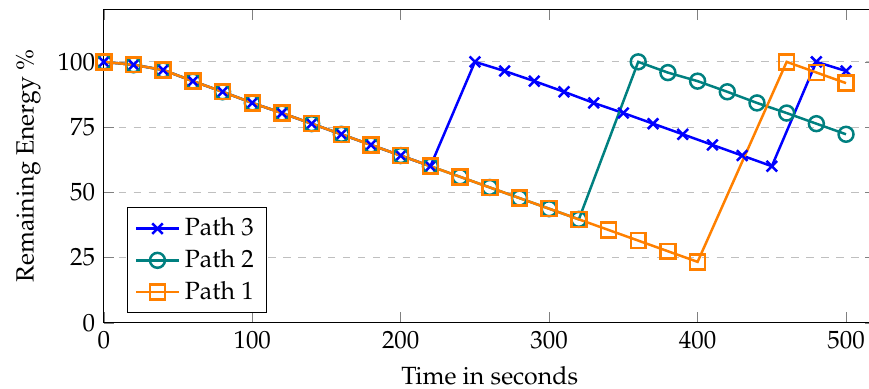
Figure 6. UAV’s residual energy with respect to time.